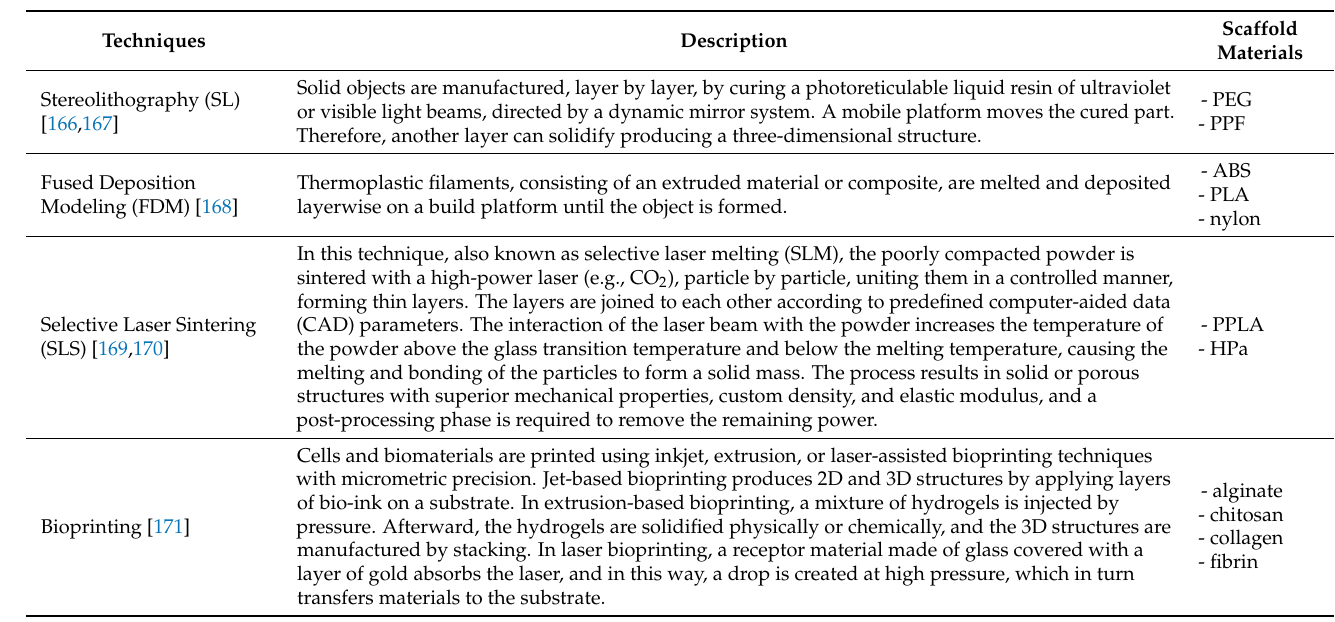
Table 3. Additive manufacturing techniques: description and typical scaffold